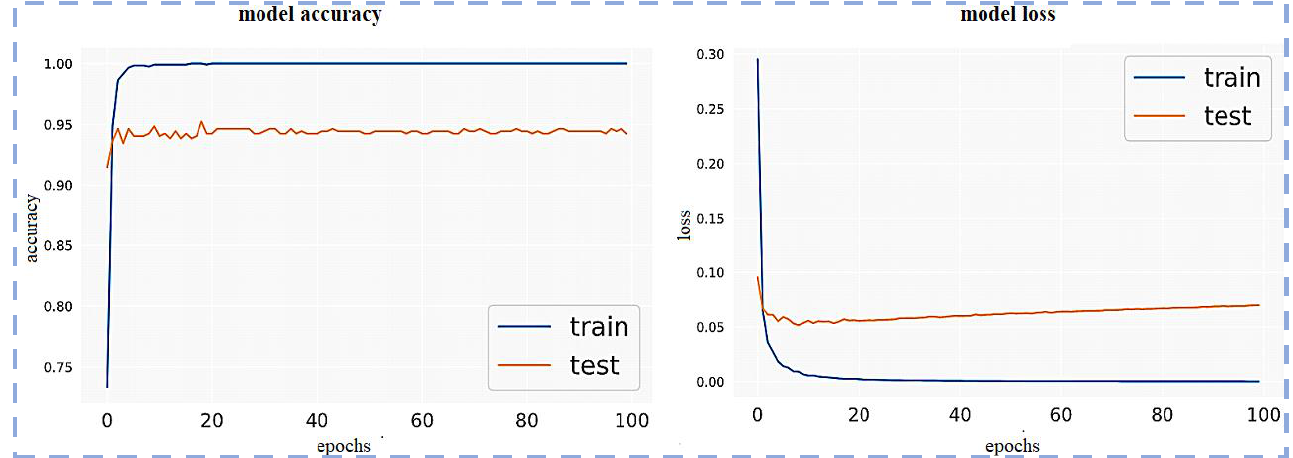
Figure 10. Model loss and model accuracy using VGG19. Figure 11 displays the VGG19 ROC Curves and Confusion matrix.